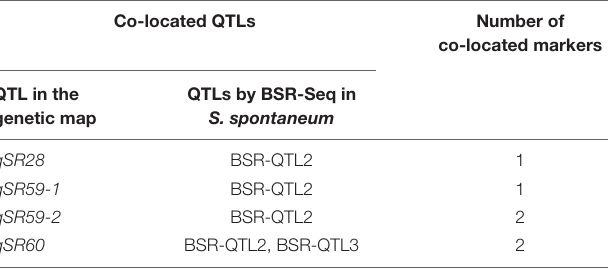
TABLE 6 | The co-located QTLs mapped in the genetic map and Saccharum spontaneum .